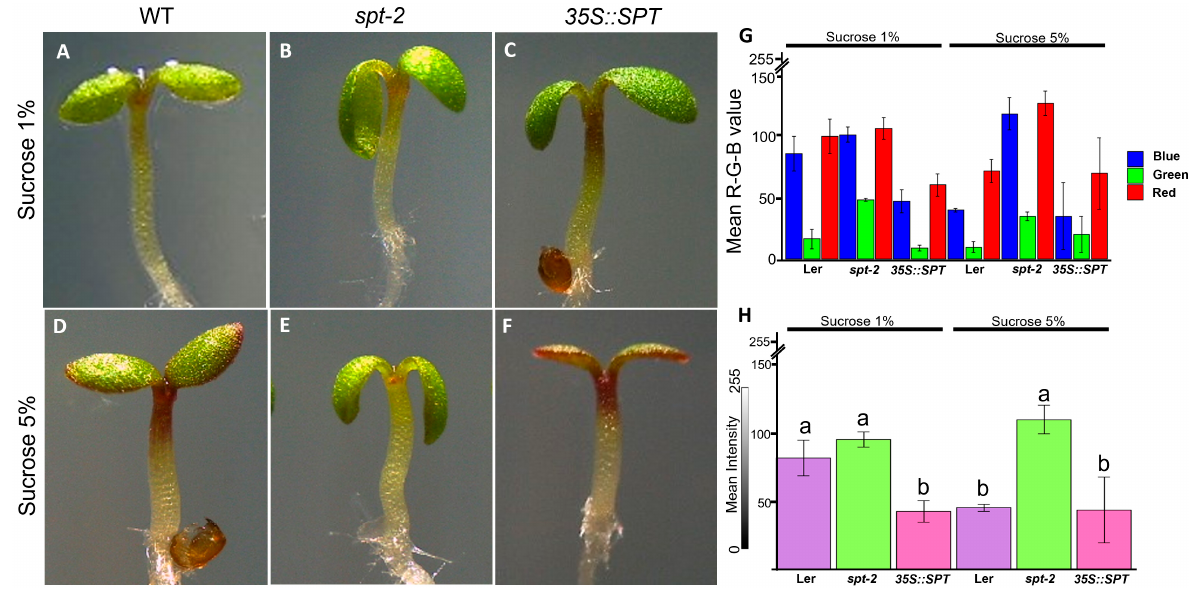
Figure 4. SPT is required for sucrose-mediated anthocyanin induction in seedlings. ( A – C ) Seedlings of WT, spt-2 , and 35S::SPT exposed to 1% sucrose. ( D – F ) Seedling of WT, spt-2 , and 35S::SPT exposed to an excess of sucrose at 5%. ( G ) Mean value of the intensities of red, green, or blue (R, G, or B, respectively) colors in WT, spt-2 , and 35S::SPT in an area of 30 × 5 pixels. ( H ) Mean value of the intensity in WT, spt-2 , and 35S::SPT in an area of 30 × 5 pixels. Statistical differences detected by one-way ANOVA and Tukey HSD at p < 0.05 are represented by different lowercase letters above the bar and histogram plots. The analyses were performed in triplicate.